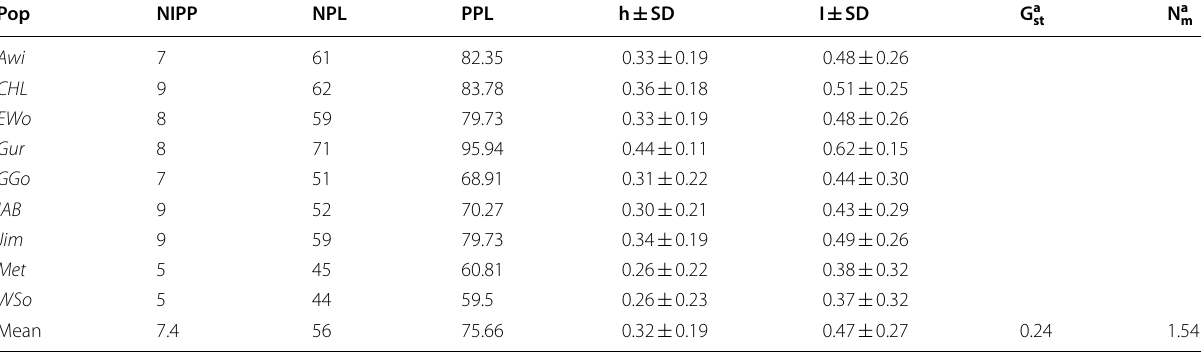
See Table 1 for the description